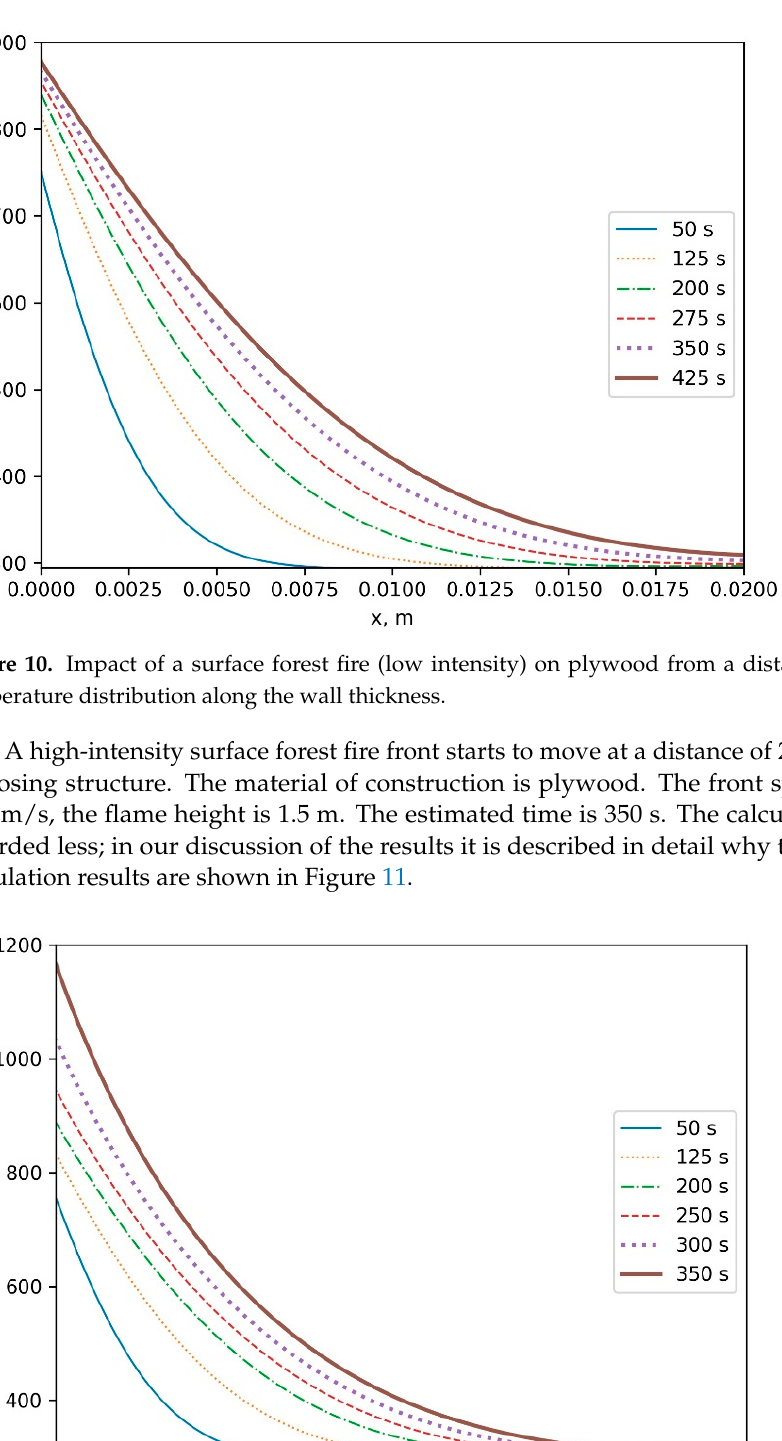
Figure 12. Impact of a crown forest fire on plywood from a distance of 20 m for different facade heights (from 1 to 10 m).